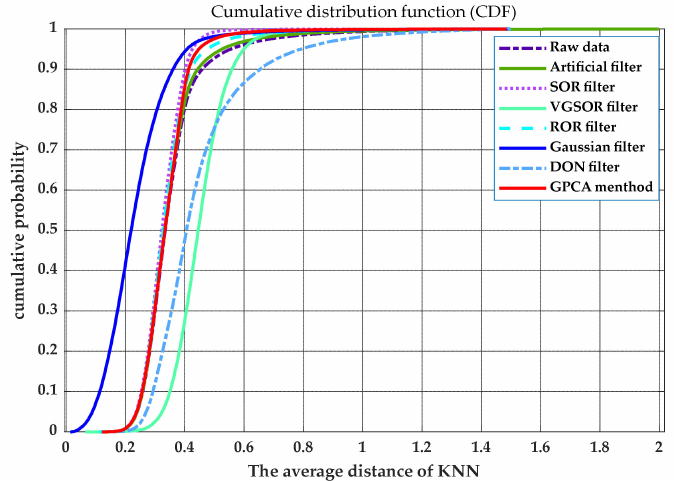
Figure 11. Cumulative distribution function (CDF) of several filters: if F ( x ) is represented as a CDF, then F ( a ) is the proportion of points for which the average distance is less than a . The faster the value of cumulative probability increases, the higher the concentration of data. Therefore, it can be used as an indicator to judge the degree of data